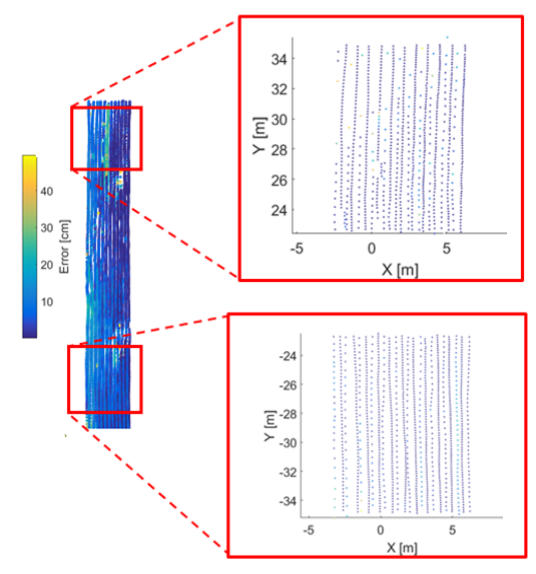
Figure 6. UWB trajectory solution from open sky test; colors indicate the difference from the GNSS solution.